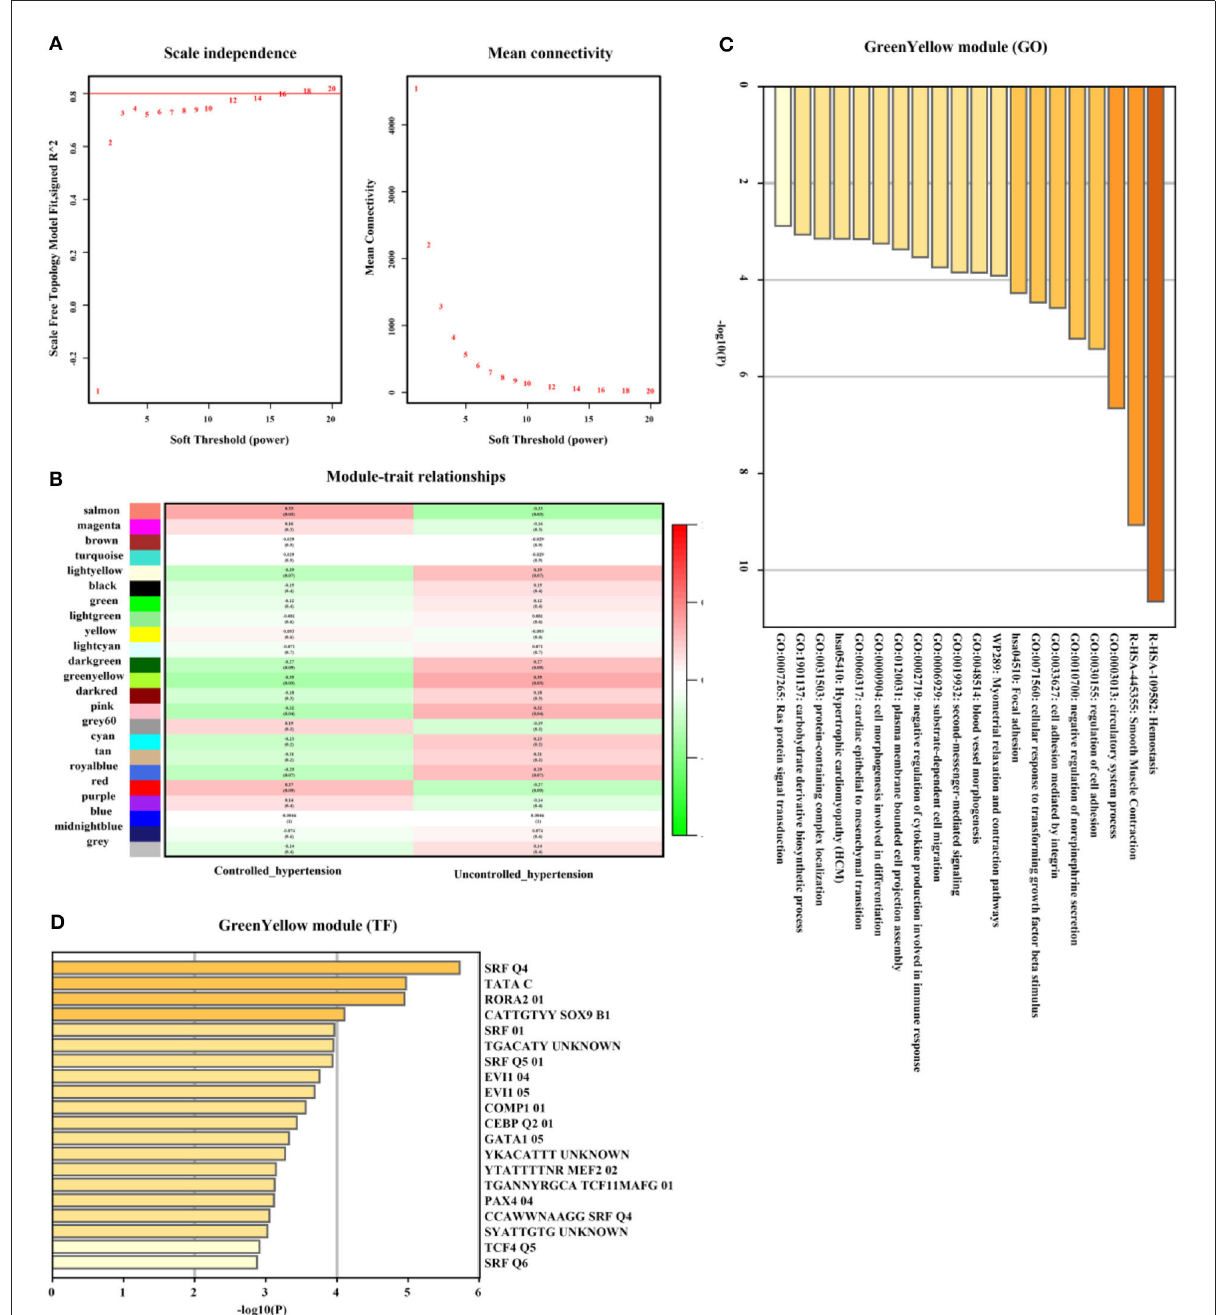
FIGURE7 Uncontrolled hypertension-related gene module selection and functional enrichment analysis (GSE71994). (A) Robust threshold value to the selection. (B) A heatmap displaying the associated with uncontrolled hypertension trait and neighboring genes modules. (C) The GO and KEGG enrichment analysis for an optimal uncontrolled hypertension-related gene module. (D) Transcript factors enrichment analysis for an optimal uncontrolled hypertension-related gene